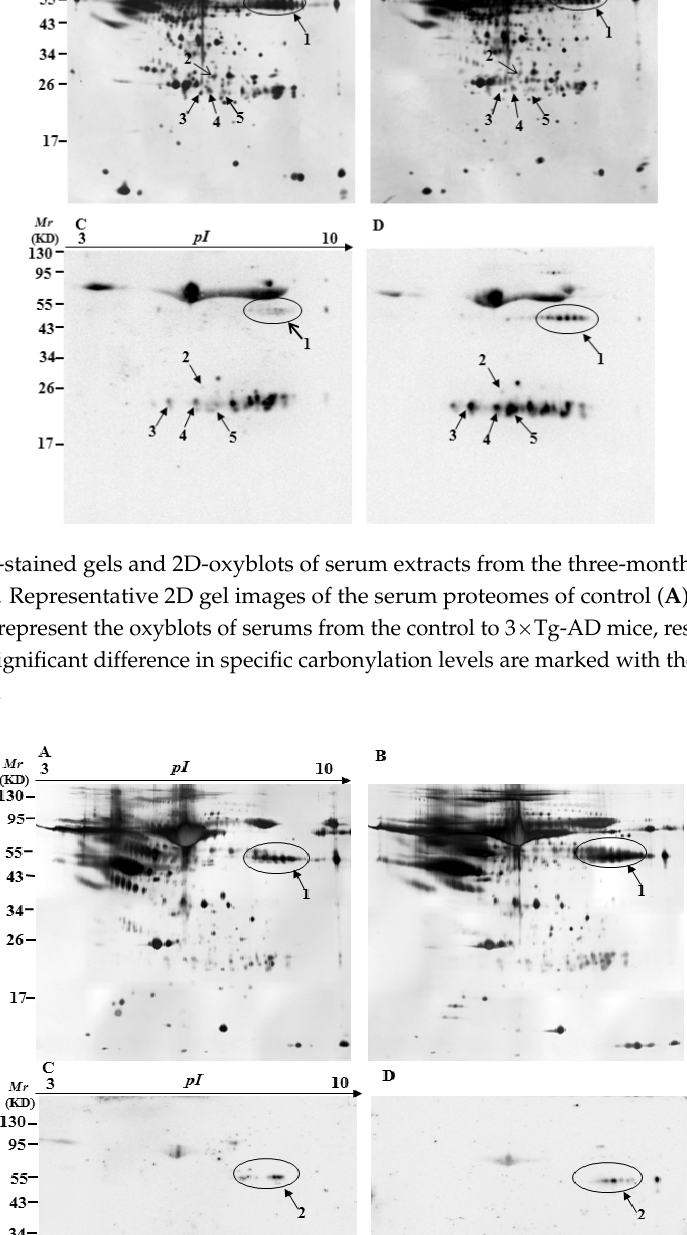
Figure 5. Silver-stained gels and 2D-oxyblots of the serum extracts from 12-month-old controls to 3×Tg-AD mice. Representative 2D gel images of the serum proteomes of control ( A ); and 3×Tg-AD mice ( B ); ( C , D ) are the oxyblots of serums from the control to 3×Tg-AD mice, respectively. Spots that showed a significant difference in specific carbonylation levels are marked with the corresponding protein identity.